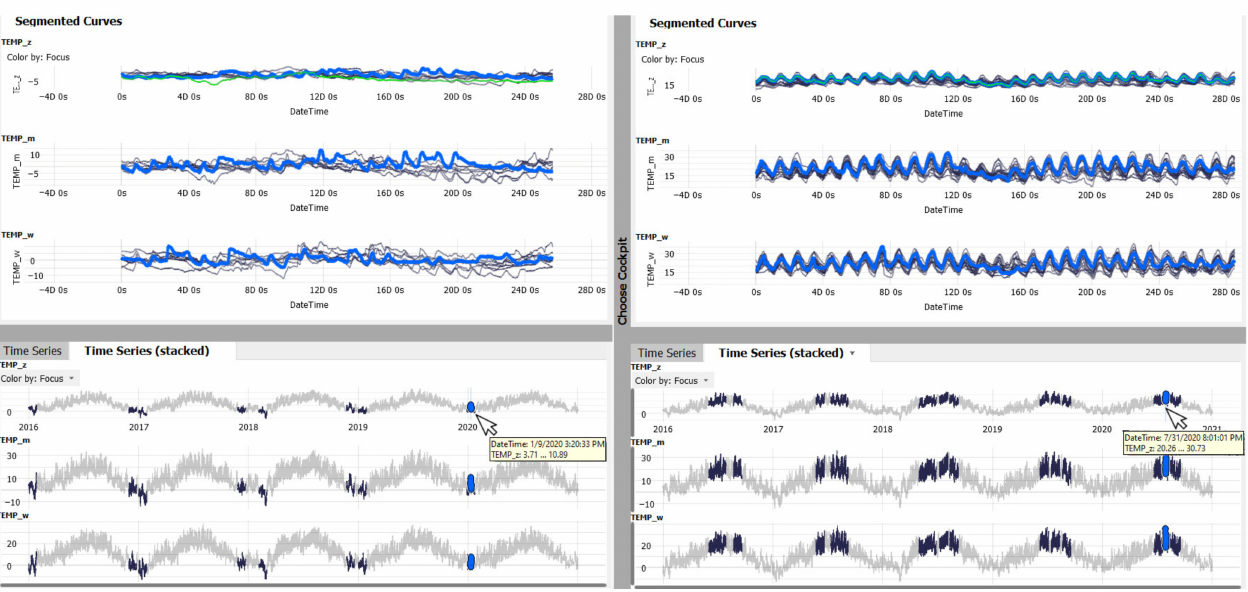
Figure 5. Annual changes observed for the solar radiation and precipitation data: ( A ) a prominent increase in solar radiation, along a more steady upward progression of precipitation events in recent periods; ( B ) higher peaks for the majority of values observed in the 2010–2020 period when compared to the rest of the dataset.